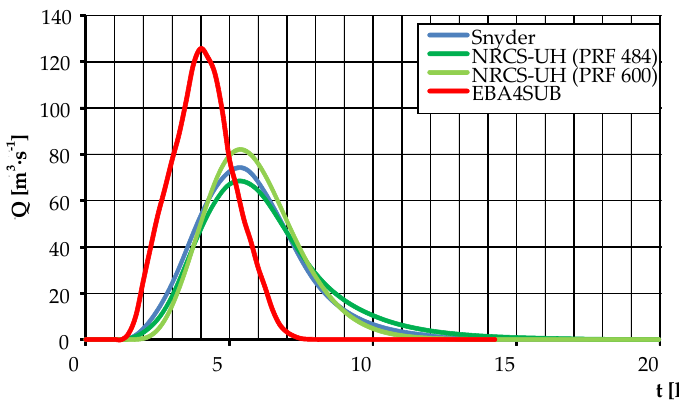
Figure 6. Design hydrograph for T = 100 years return period.